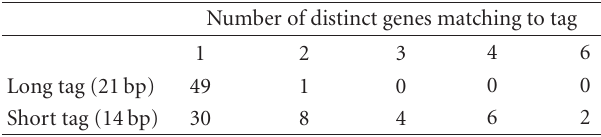
Table 2: Summary of BLAST search of 50 most expressed tags of L. i. chagasi as Long or Short tag.